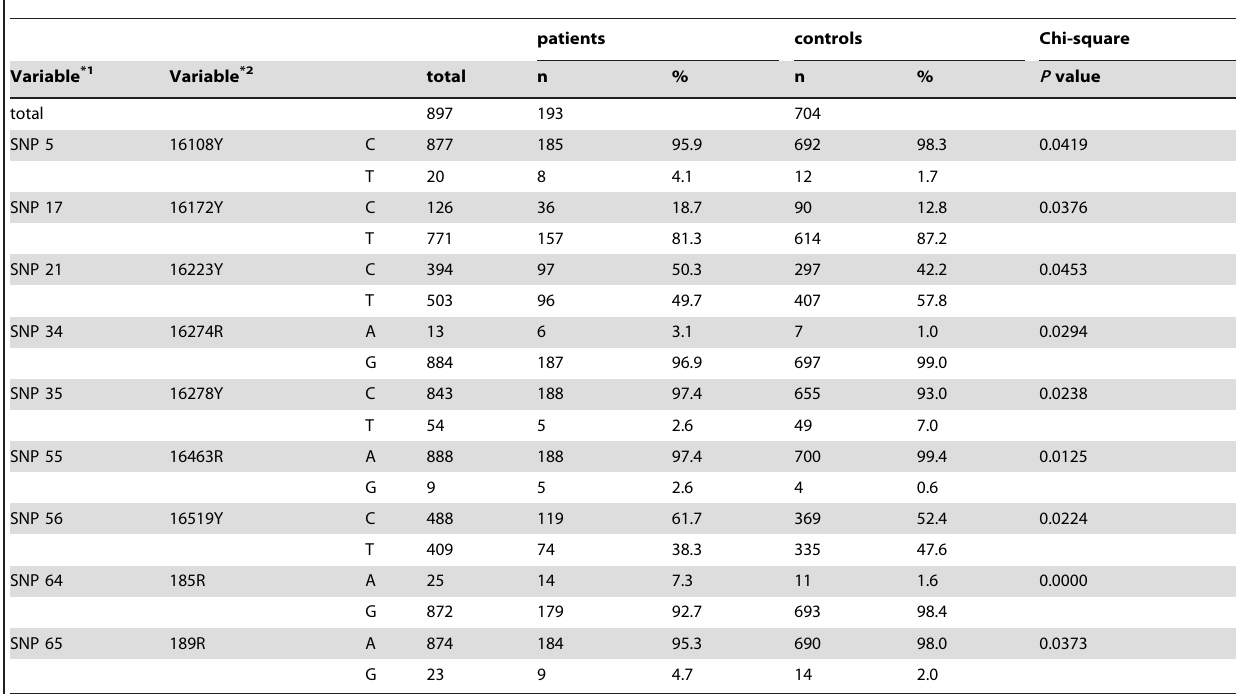
Table 3. The 9 SNPs with significantly different genotype distributions between patients and controls.